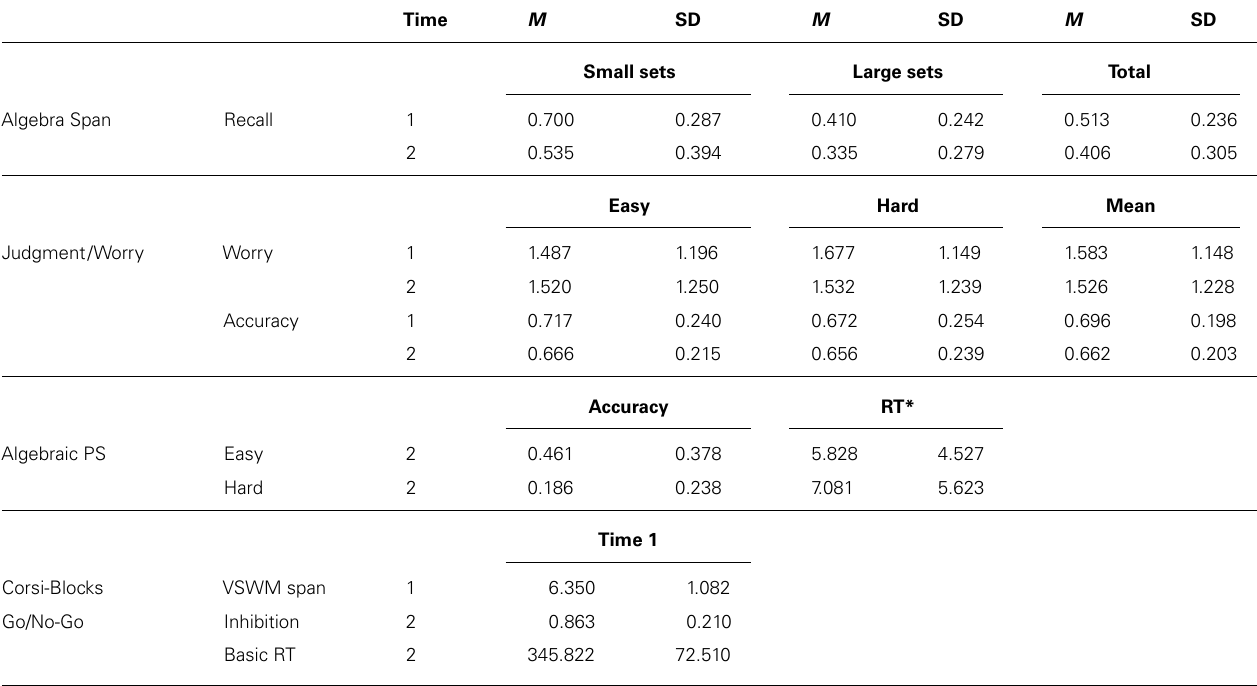
Table 1 | Means and standard deviations for working memory, worry/judgment, algebra problem solving performance,VSWM, inhibition, and basic response time.